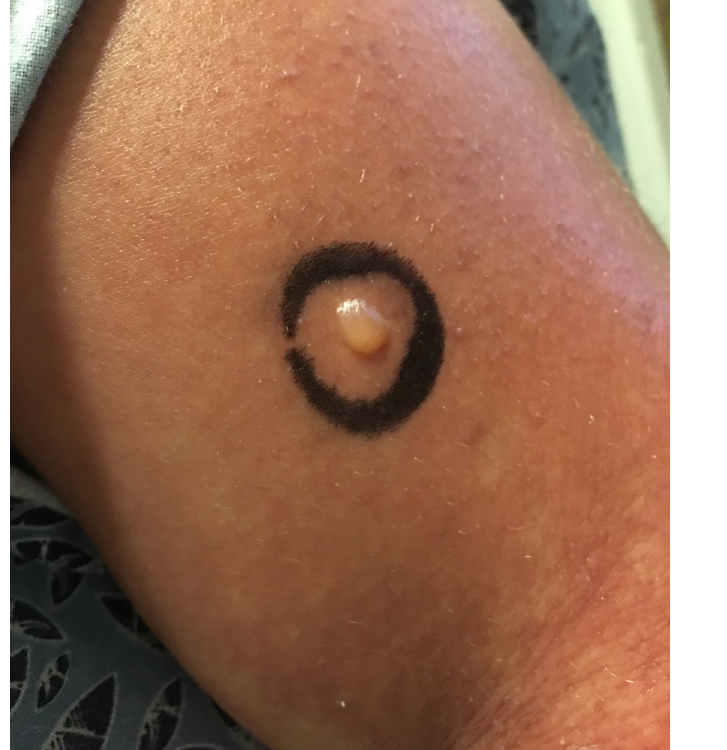
Image 3. Initial bulla (circle) on upper extremity in toxic epidermal necrolysis, approximately 22 hours after initial